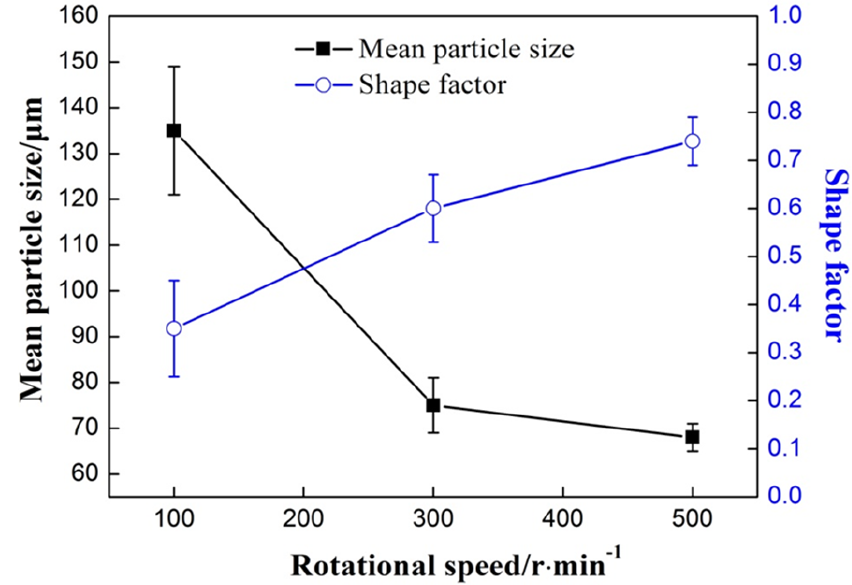
Figure 8. Variations of primary particle mean size and shape factor with rotational